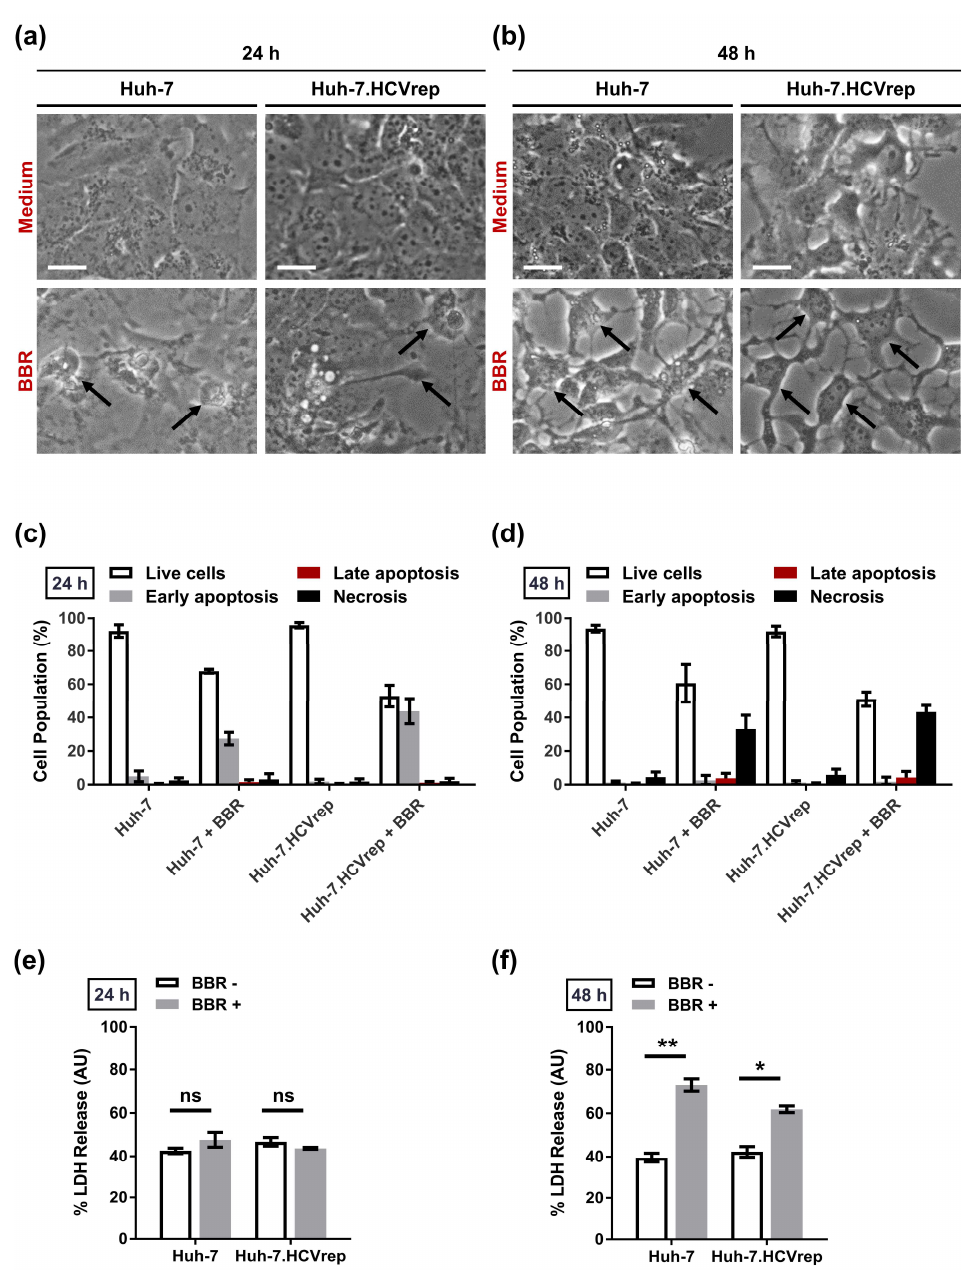
Figure 2. Berberine (BBR) induced biphasic cell death in the hepatoma cells. ( a , b ) Huh-7 and Huh-7.HCVrep cells were seeded in six-well plates (5 × 10 5 cells / well) and treated with or without 100 µ M BBR for ( a ) 24 or ( b ) 48 h. Changes in the morphology of the cells were observed using a microscope (indicated by black arrows). Magnification = 200 × ; scale bar = 25 µ m. For cell death analysis, cells treated for ( c ) 24 or ( d ) 48 h were subjected to Annexin V / Propidium Iodide (PI) staining for flow cytometry cell death analysis. For lactose dehydrogenase (LDH) release assay, cells were seeded in 96-well plates and treated with 100 µ M BBR for ( e ) 24 or ( f ) 48 h before analysis of LDH release. Results are shown as means ± SD from three independent repeats for a, b, c, and d, and two independent repeats for e and f. * p < 0.05; ** p < 0.01; ns = not